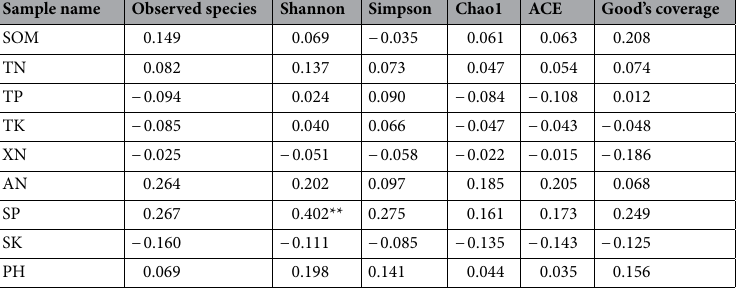
Table 7. Correlation between soil fungal Alpha diversity index and soil physical and chemical properties. *Means 0.05 level has significant correlation ( P < 0.05). **Means 0.01 level has extremely significant correlation ( P < 0.01).